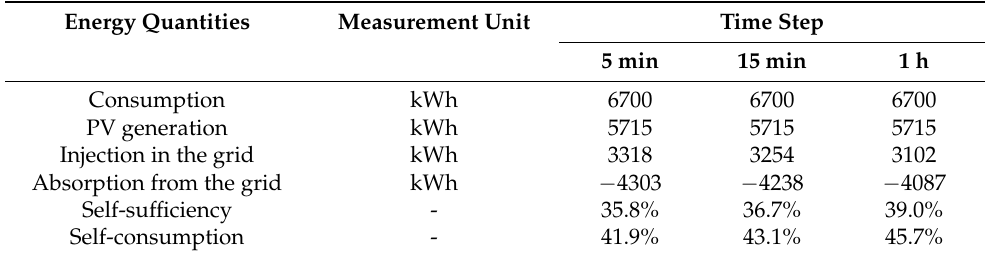
Table 2. Energy quantities related to the example in Figure 3: yearly